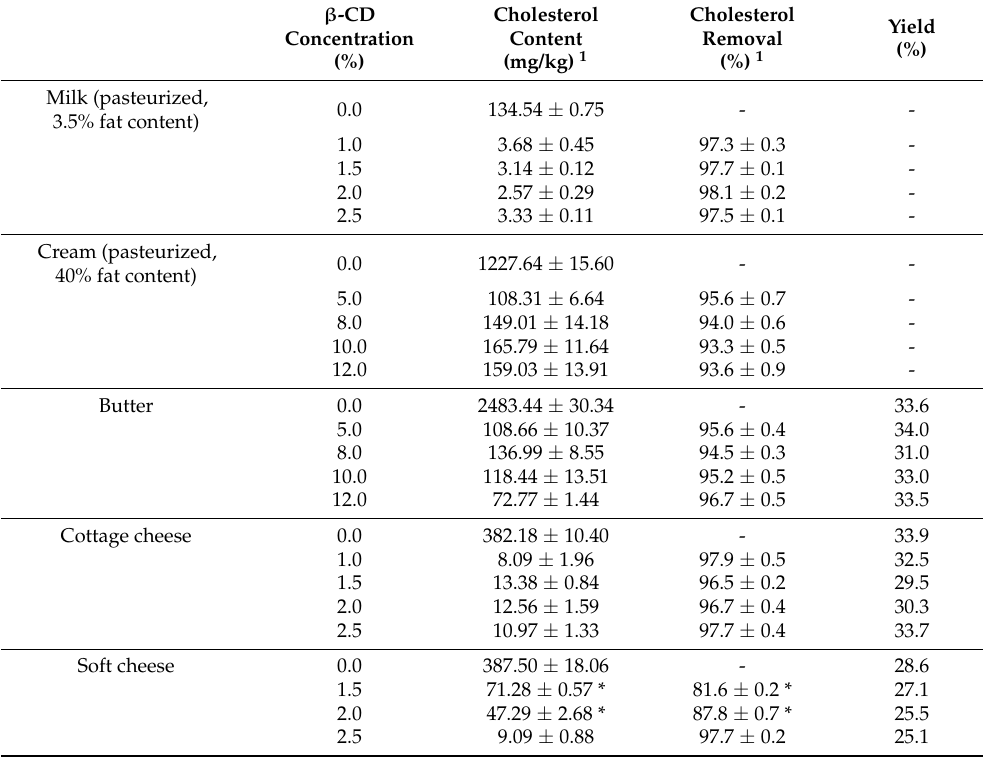
Table 1. The effect of the concentration of β -CD ( w / w ) on the removal of cholesterol content in dairy